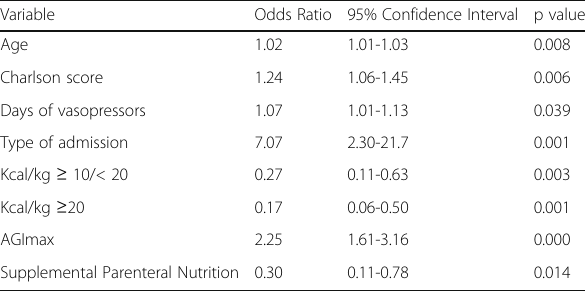
Table 3 (abstract 0042). Multiple logistic regression model for hospital mortality